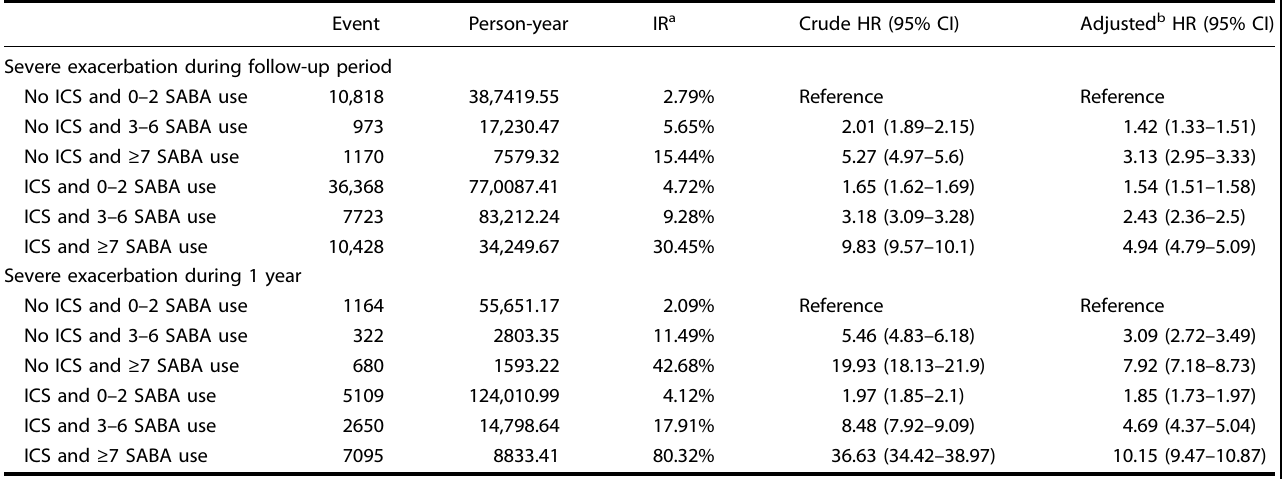
Table 3. Association between baseline ICS and SABA use and risk of severe exacerbation.